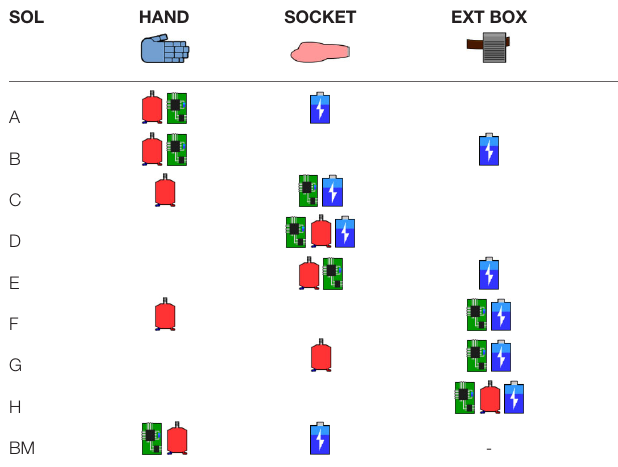
TABLE 1 | Summary of hybrid component locations for 8 feasible solutions (Piazza et al., 2017) and, for reference, myoelectric solution (BM) component location (Godfrey et al.,